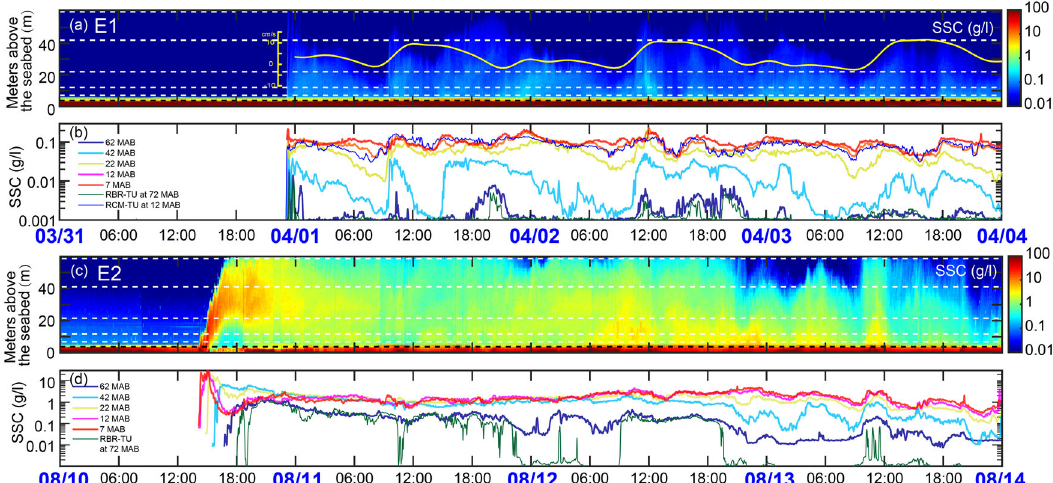
Fig. 4 Sediment concentration pro fi les of the turbidity currents E1 and E2 at the mooring site S2. a Pro fi les of the inverted SSC for E1. The area under the black dashed line was affected by the side lobe interference. The yellow line indicates the local tidal oscillation (positive value is ebb phase). b Plots of the inverted SSC at 7, 12, 22, 42 and 62 MAB for E1, and the calculated SSC from RBR-TU at 72 MAB and RCM-TU at 12 MAB. Different colors represent the SSC in different heights those are indicated by white dashed lines in ( a ). c Inverted SSC pro fi les for E1. d Plots of the inverted SSC at 7, 12, 22, 42 and 62 MAB for E2, and the calculated SSC from RBR-TU at 72 MAB. Different colors represent the SSC in different heights those are indicated by white dashed lines in ( c ). Only the SSC after E1 and E2 happening was